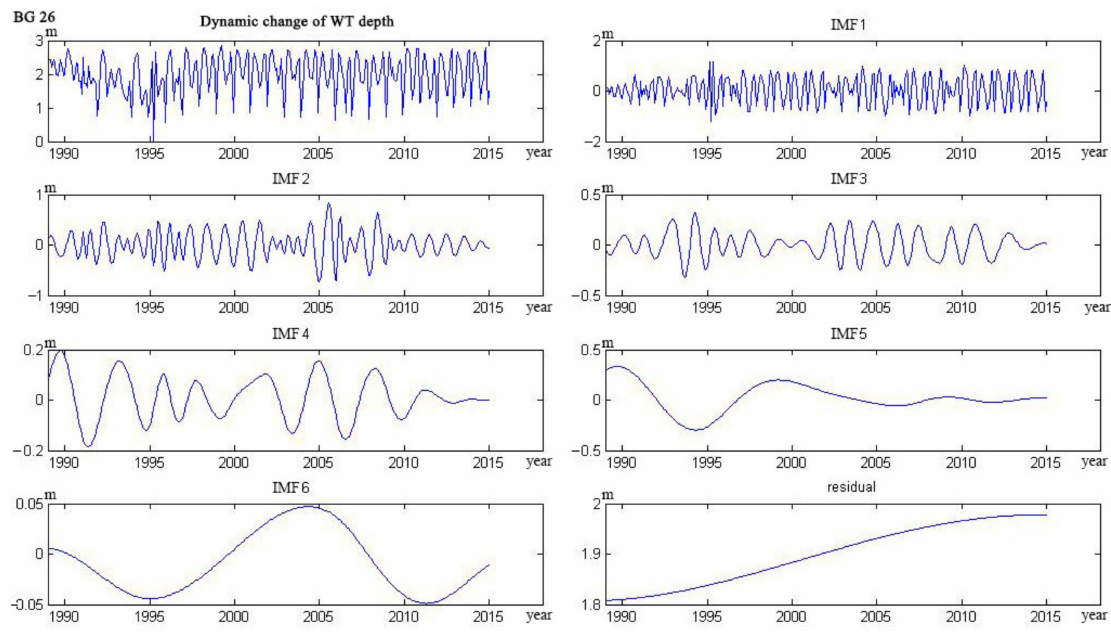
Figure A17. Decomposition of groundwater time series data of well BG26.